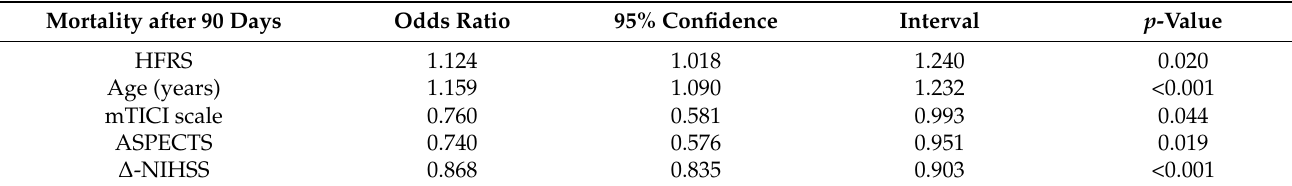
Table 5. Multivariate logistic regression analysis of Influence on mortality after 90 days; HFRS: Hospital Frailty Risk Score, mTICI scale: modified thrombolysis in cerebral infarction scale, ASPECTS: Alberta Stroke Program Early CT Score, mRS: modified Rankin Scale, NIHSS; National Institute of Health Stroke Score, Δ‐ NIHSS: difference between the NIHSS at admission and discharge.